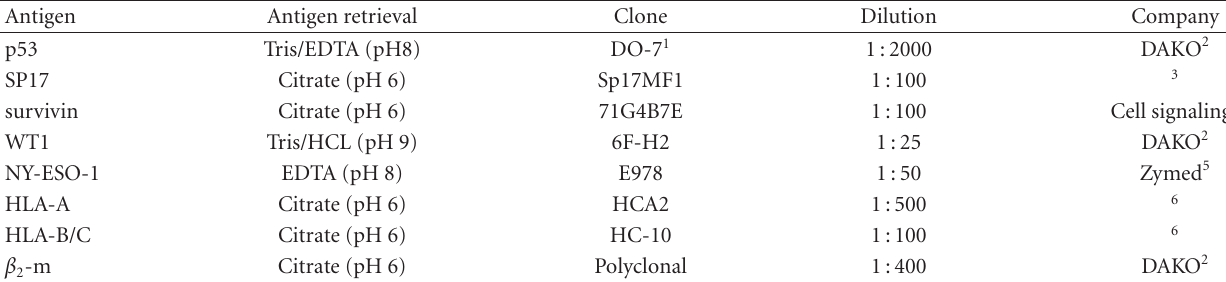
Table 1: Antibodies used for immunohistochemical staining.